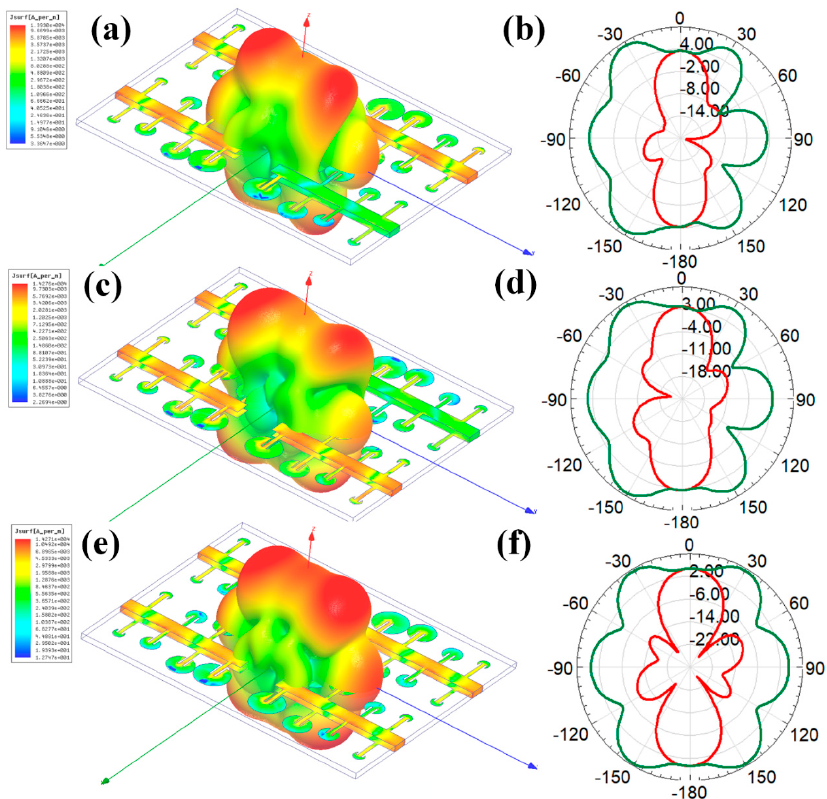
Figure 9. Variation in gain for the different modes of port excitation, along with co- and cross-polarization effects. Three-dimensional directivity with co- and cross-polarization for port excitation conditions of (P1, P2, P3, P4): ( a ) (1, 0, 1, 1), ( c ) (0, 1, 1, 1), and ( e ) (1, 1, 1, 1). Two-dimensional directivity with co- and cross-polarization for port excitation conditions of (P1, P2, P3, P4): ( b ) (1, 0, 1, 1), ( d ) (0, 1, 1, 1), and ( f ) (1, 1, 1, 1). co- (green line) and cross-polarization (red line).